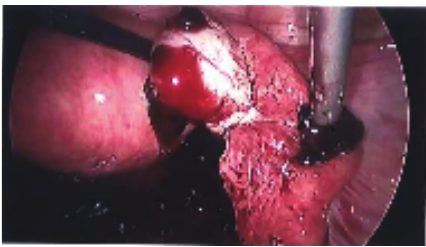
Figure 2: Only identifiable source of haemorrhage from corpus luteal